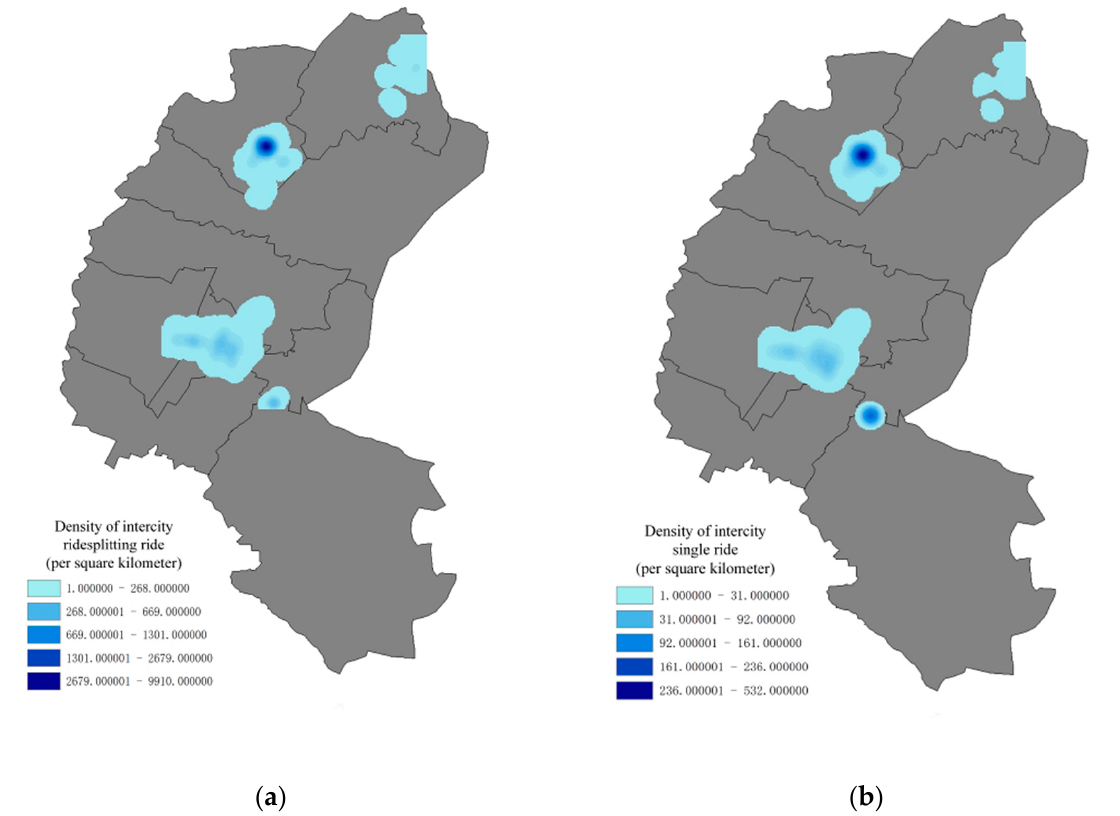
Figure 6. ( a ) Spatial distribution of intercity ridesplitting ride; ( b ) spatial distribution of intercity single ride.